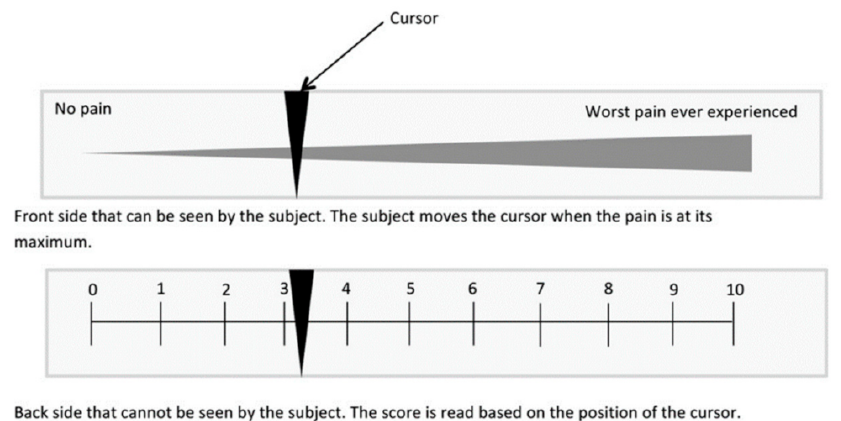
Figure 4. Visual analogical pain scale used for pain measurement during treatment. Reproduced with permission from